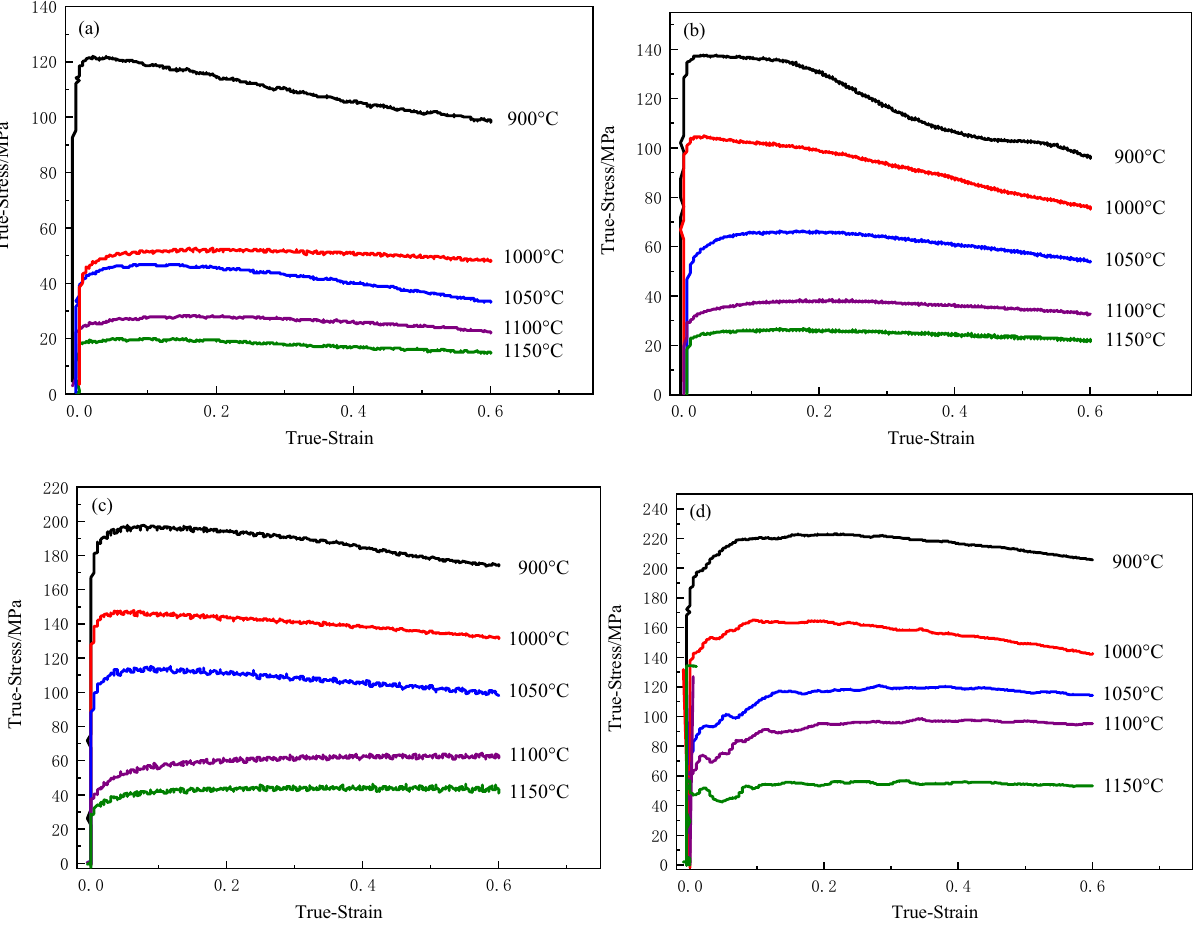
Figure 3: True stress - true plastic strain plots for the 9Cr3W3Co - ODS steels obtained at a series of hot compressive deformation parameters: (